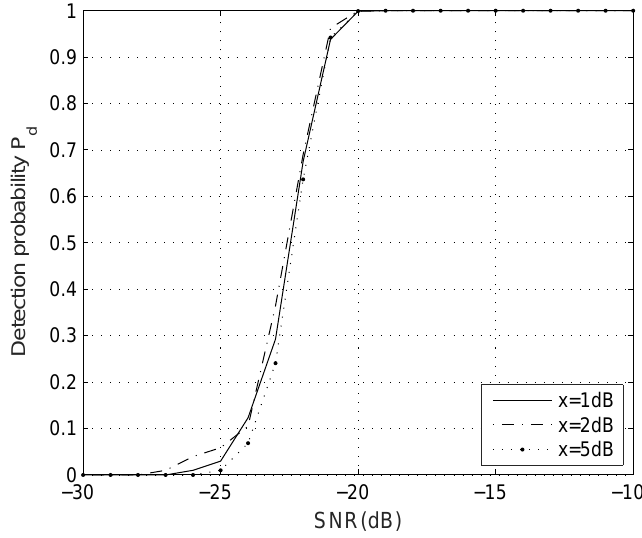
Figure 8. The influence of noise uncertainty on detection